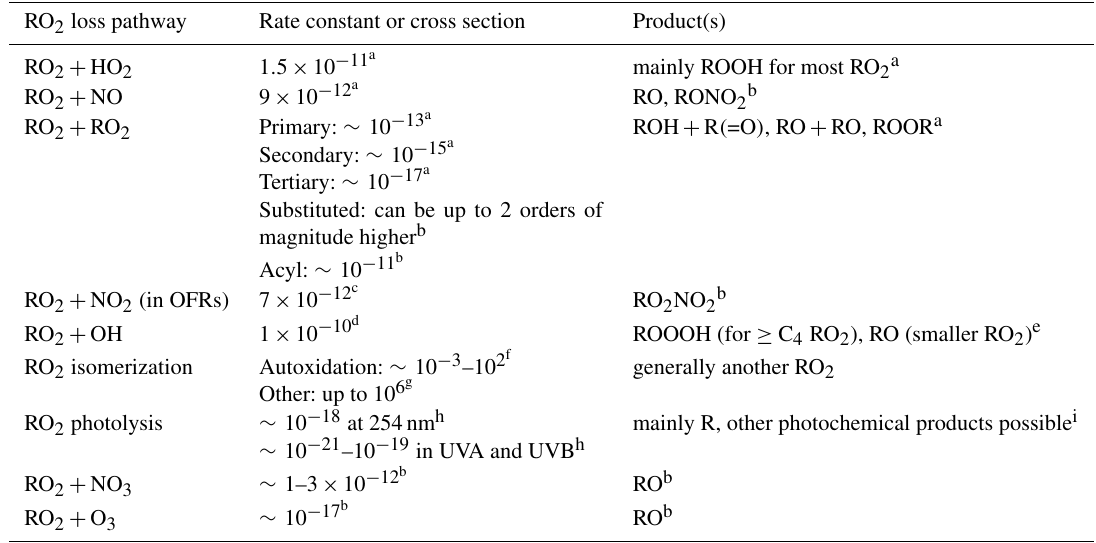
Table 1. Rate constants (in cm 3 molecule − 1 s − 1 except for isomerization; in s − 1 ) , cross section (in cm 2 ) and product(s) of RO 2 loss path- ways. Only organic species are listed for